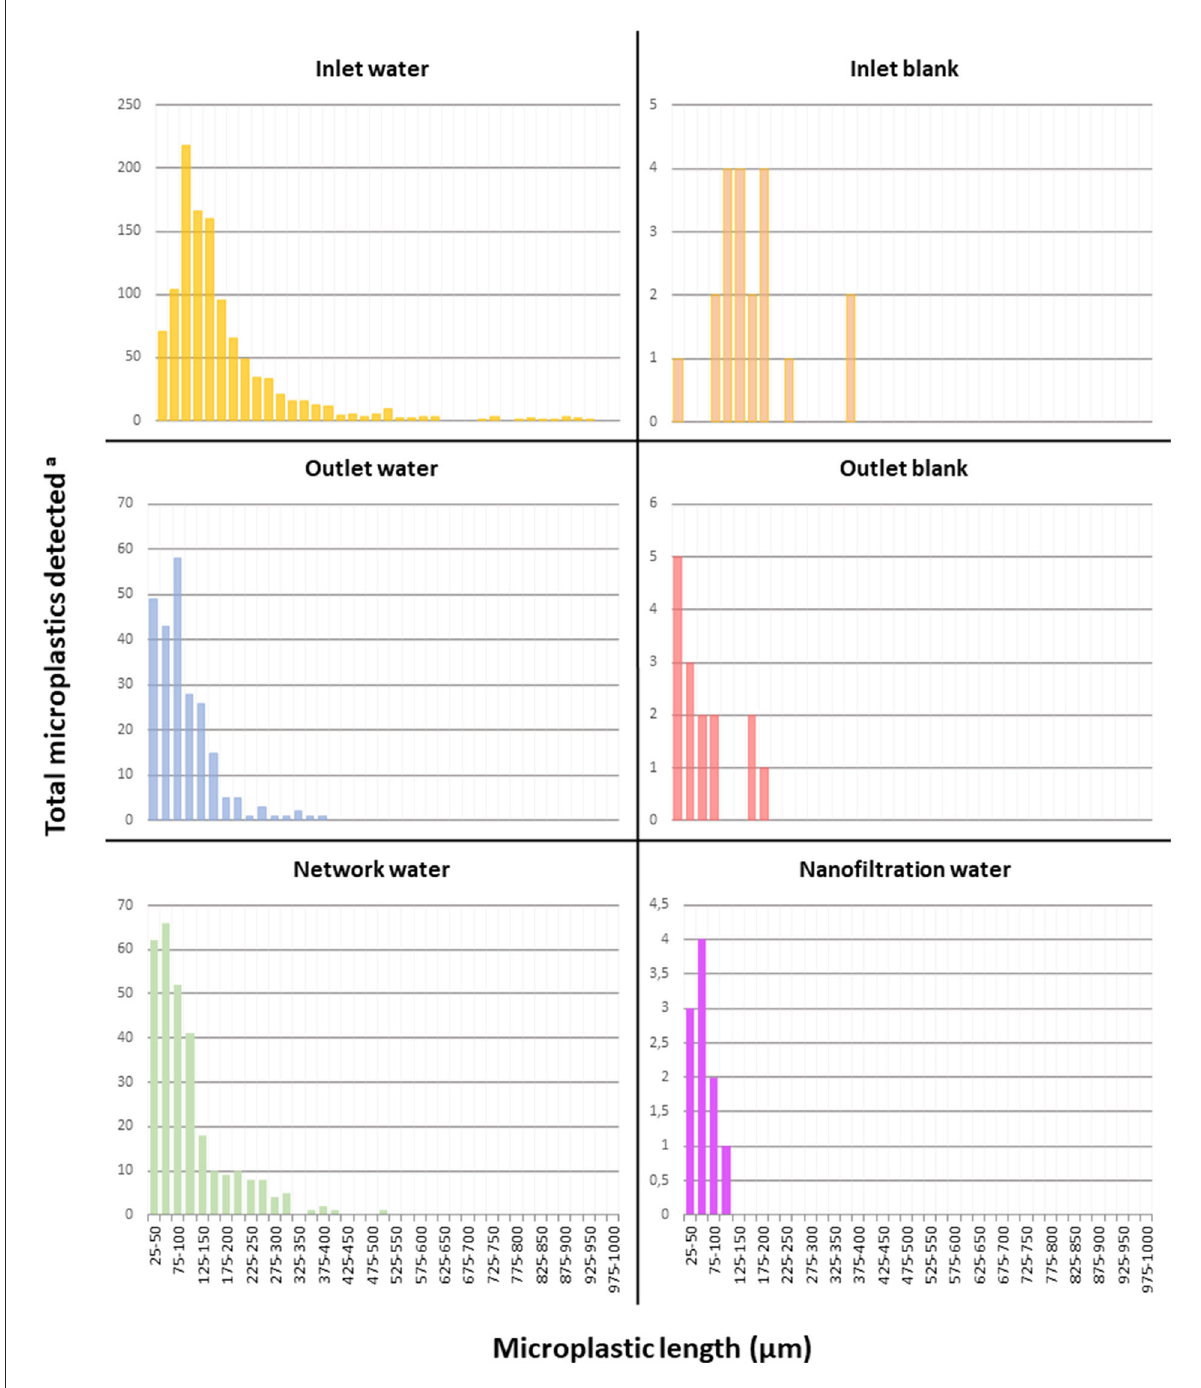
FIGURE4 Microplastic size distribution per sample type. a Sum of detected microplastics across all samples for each sample type and length range. Inlet water: n = 9; Inlet blank: n = 4; Outlet water: n = 9; Outlet blank: n = 12; Network water: n = 6; Nanofiltration water n = 6.